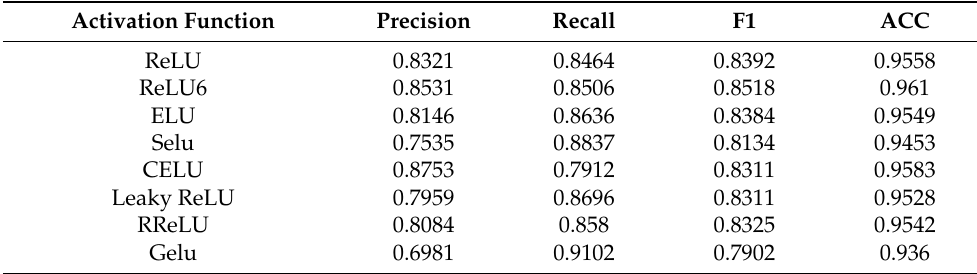
Table 7. Compare Different activation functions on CAEIE. Activation Function Precision Recall F1 ACC ReLU